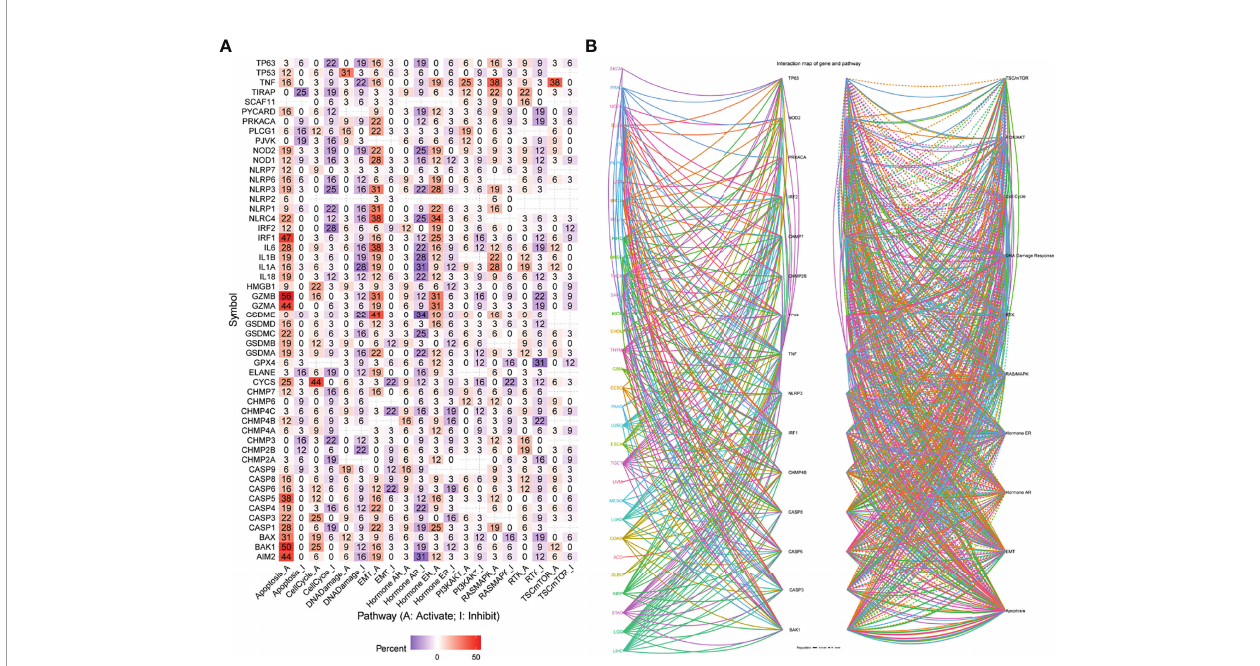
FIGURE 7 | (A) Percentage of cancers in which mRNA levels of speci fi c genes have potential pathway activity. (B) Network of the relationship between genes and pathways. Solid lines represent activation, dashed lines inhibition, and the color of the lines represents different cancer